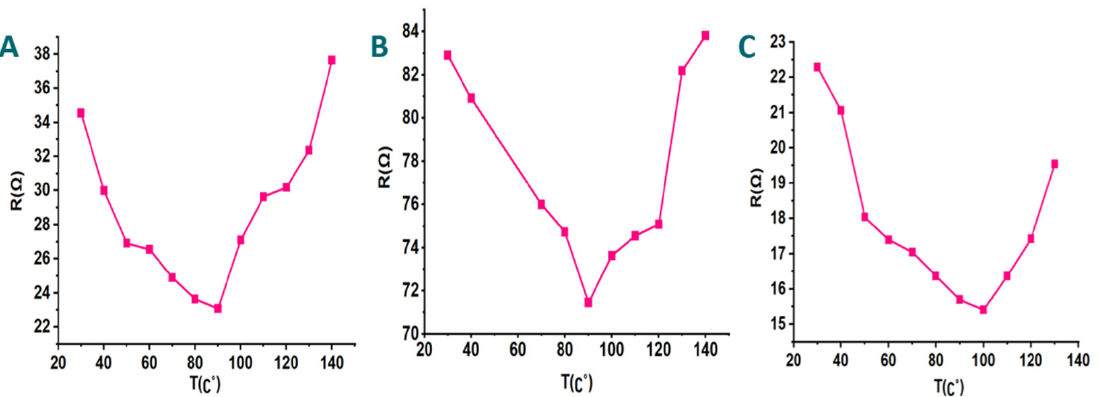
Figure 3. Resistance of graphite-based cotton as a function of temperature; ( A ) low concentration of 20 wt.%; ( B ) medium concentration of 30 wt.%; and ( C ) high concentration of 78.78 wt.%.